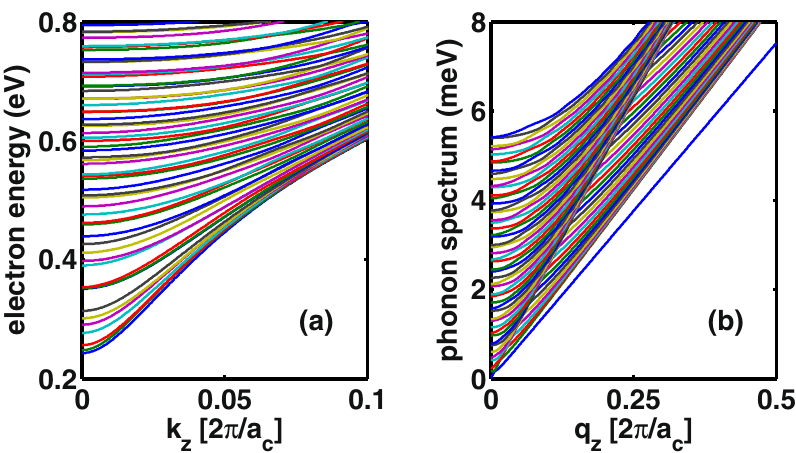
Figure 1. ( a ) Conduction subbands of InSb nanowire along the [001] direction with diameter 51.8 nm, based on the k · p theory calculation. ( b ) Phonon spectrum of the same InSb nanowire calculated from a continuum media model. In both plots, a c is the lattice